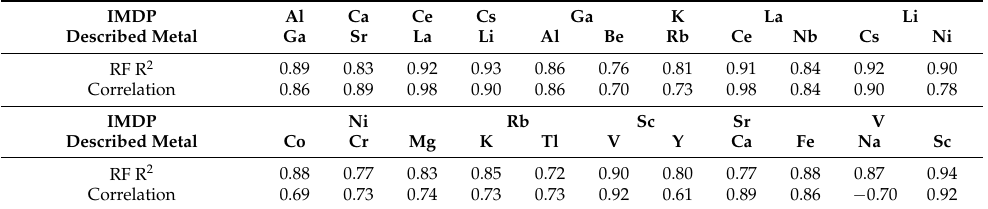
Table 2. The 22 metals for which the RF model performance exceeded an R 2 of